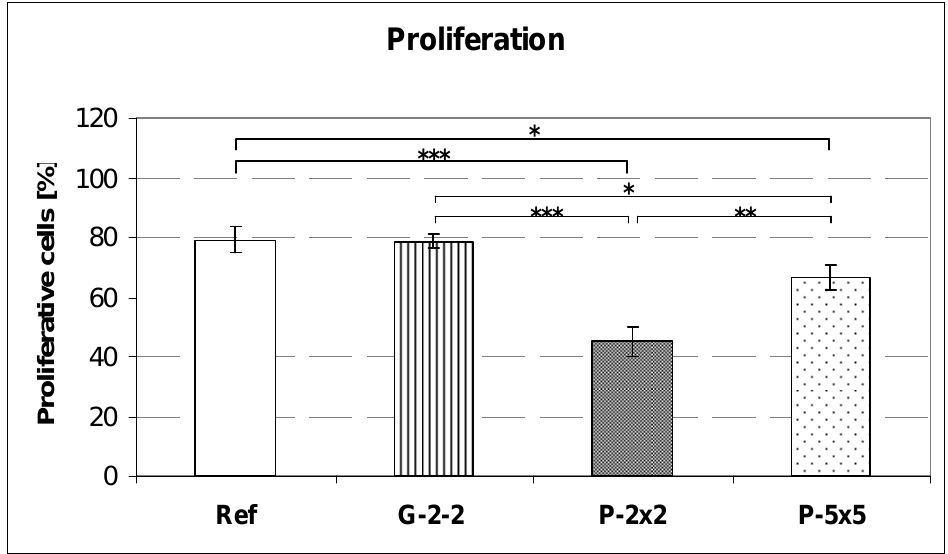
Figure 6. Flow cytometric analysis of the proliferative activity of MG-63 osteoblasts on microtextured titanium surfaces after 24 h. Cell proliferation on the pillared surfaces P-2×2 and P-5×5 is reduced compared to the control (Ref). In contrary, cell proliferation of MG-63 osteoblasts on the grooved surface G-2-2 is similar to that of cells grown on the planar reference (Ref) (mean ± SD; * p < 0.05, ** p < 0.01, *** p < 0.001, unpaired t -test, n = 3 à 20,000 cells) (FACSCalibur, BD